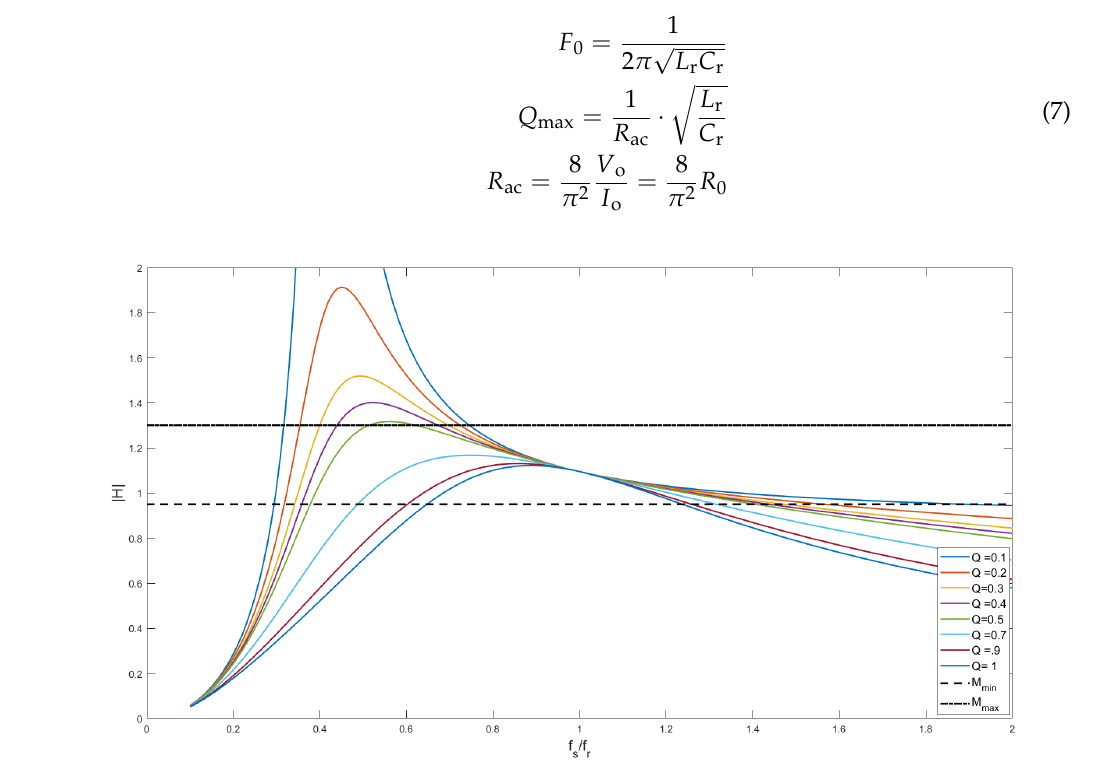
Figure 9. Gain curve of LLC converter plotted with m = 6 and variable Q max